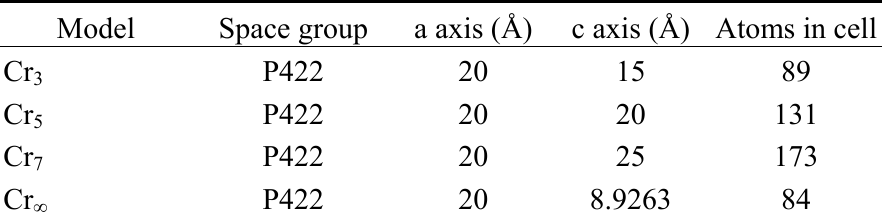
; and (d) is for Cr 7